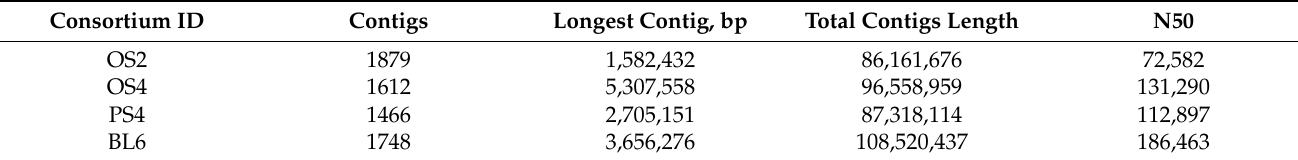
Table 2. Characteristics of assembled metagenomes of isolated microbial